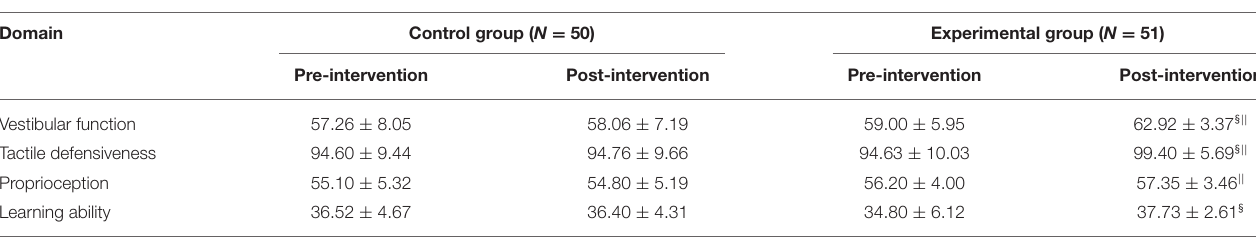
TABLE 6 | Results of sensory integration.